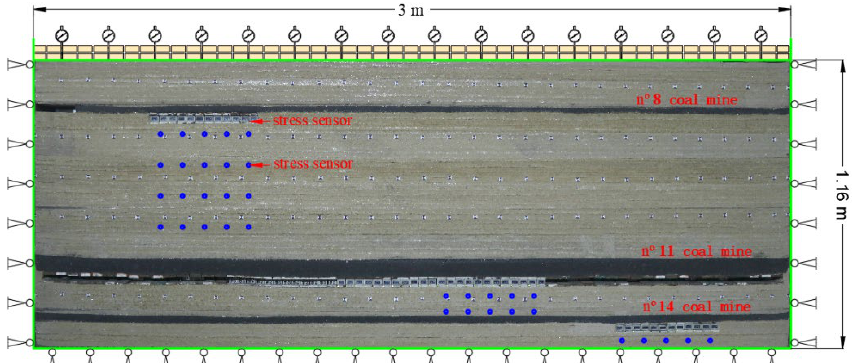
Figure 6. Similar simulation experimental model (similarity ratio of 1:100).